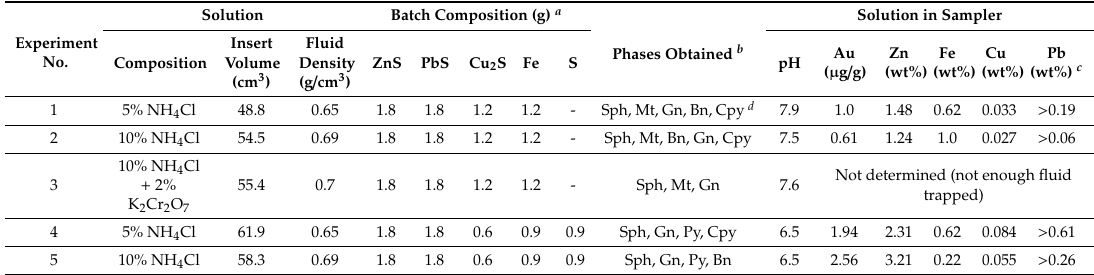
Table 1. Conditions and results of hydrothermal experiments on synthesis of multiphase assemblages and study of Au partitioning at 450 ◦ C and 1 kbar pressure. Experiment